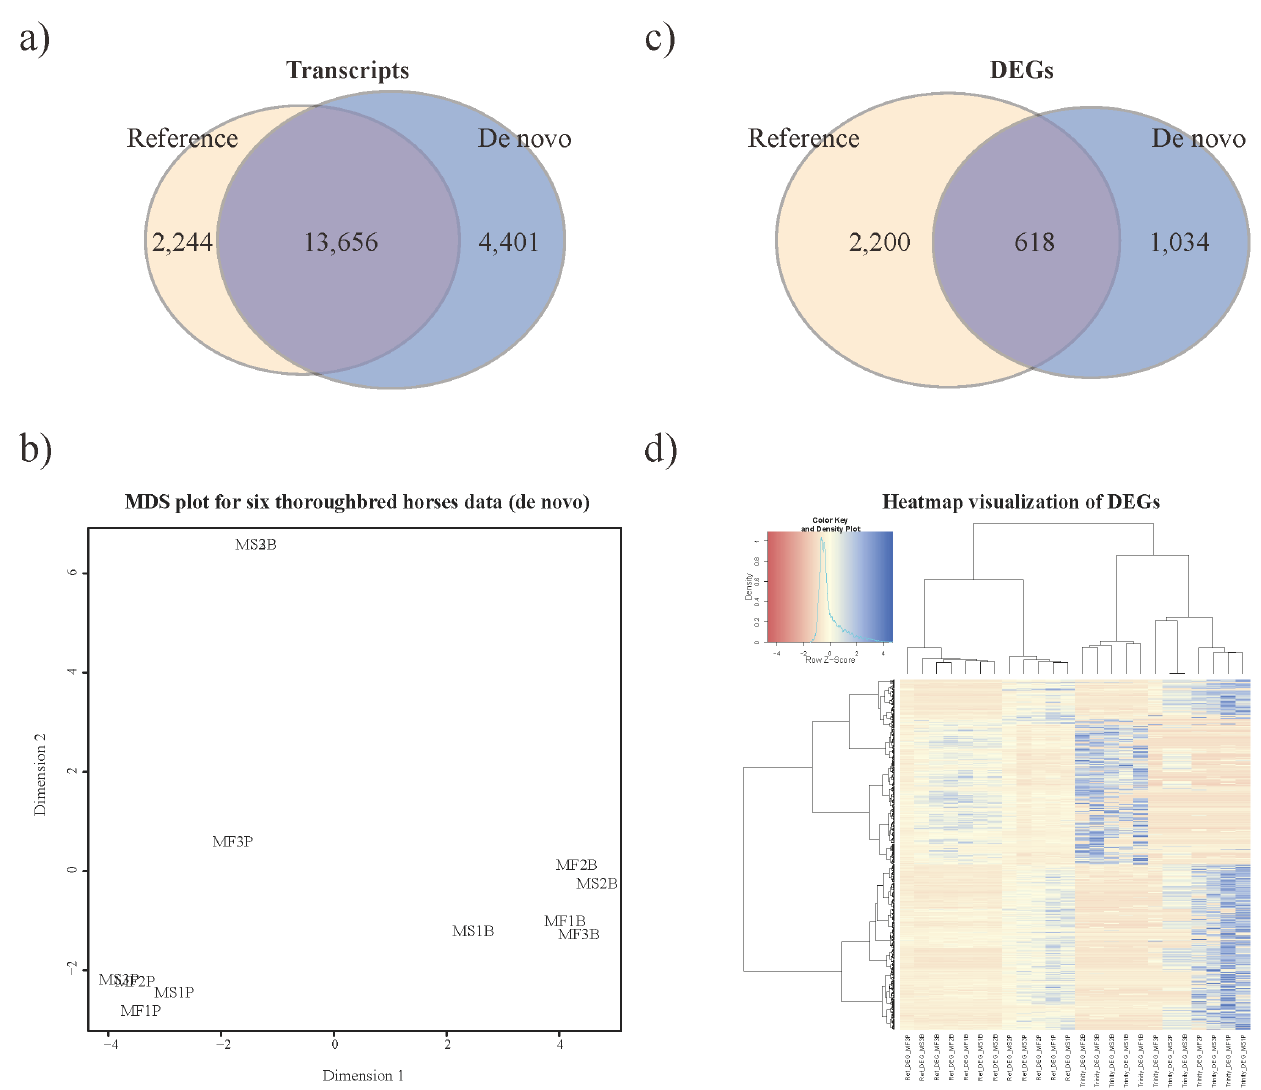
Figure 1. Summary of comparative analysis between denovo assembly and reference genome assembly from RNA-seq data of skeletal muscle from six Thoroughbreds before and after exercise (Total 12 samples). a) The number of transcripts in common between de novo assembly and reference genome assembly b) MDS plot of six Thoroughbreds before and after exercise using de novo assembly. c) The number of DEGs between de novo assembly and reference genome assembly. d) Heat-map visualization of common DEGs between de novo assembly and reference genome assembly: rows represent DEGs from skeletal muscle and columns represent assemble method from 6 horse samples (*First ‘B’ is for blood and ‘M’ is for muscle. ‘F1’, ‘F2’, ‘F3’ and ‘S3’ are horse samples. Last ‘B’ is for ‘before exercise’ and ‘P’ is for ‘after